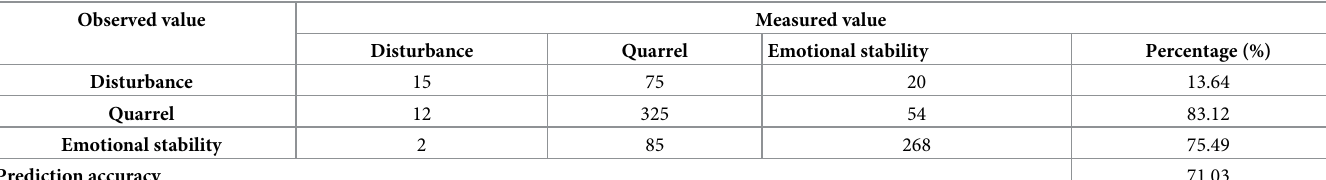
Table 8. Model prediction accuracy.